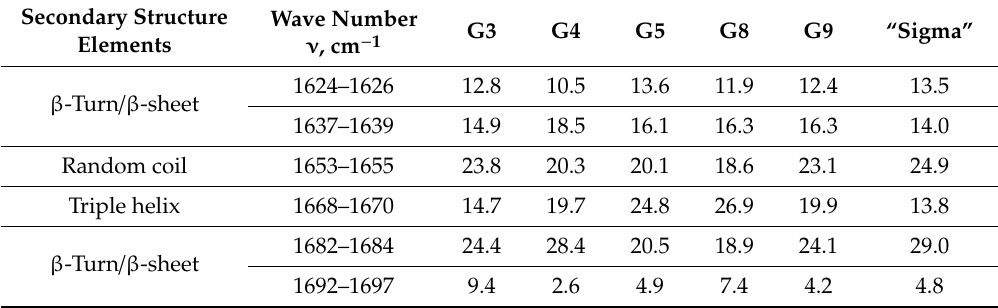
Table 5. Content (as a percentage) of major components of the secondary structure of the protein in cod gelatin samples obtained at different pH.